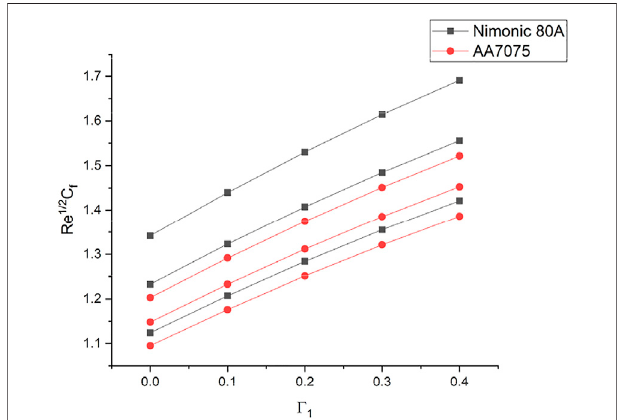
FIGURE 11 | Change in Re − 1/2 Nu for β versus B p .